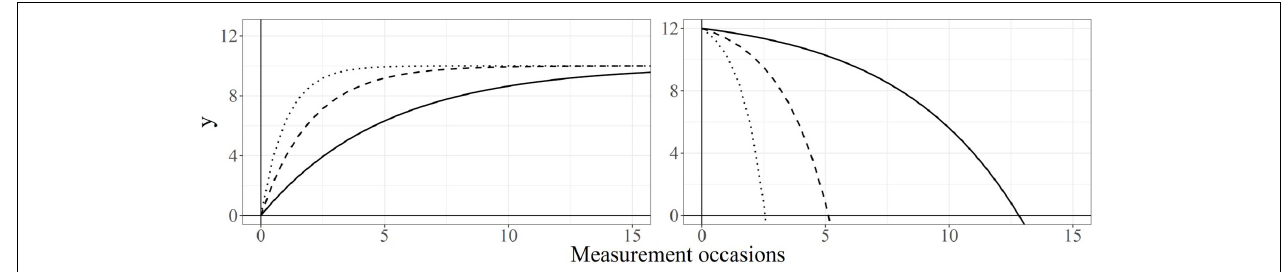
FIGURE 4 | Grand-mean implied trajectories of decelerated growth and accelerated decay. Note: Values of self-feedback β = − 0.2, − 0.5, − 1 (left) and β = 0.2, 0.5, 1 (right) are represented by solid, dashed, and dotted lines, respectively.